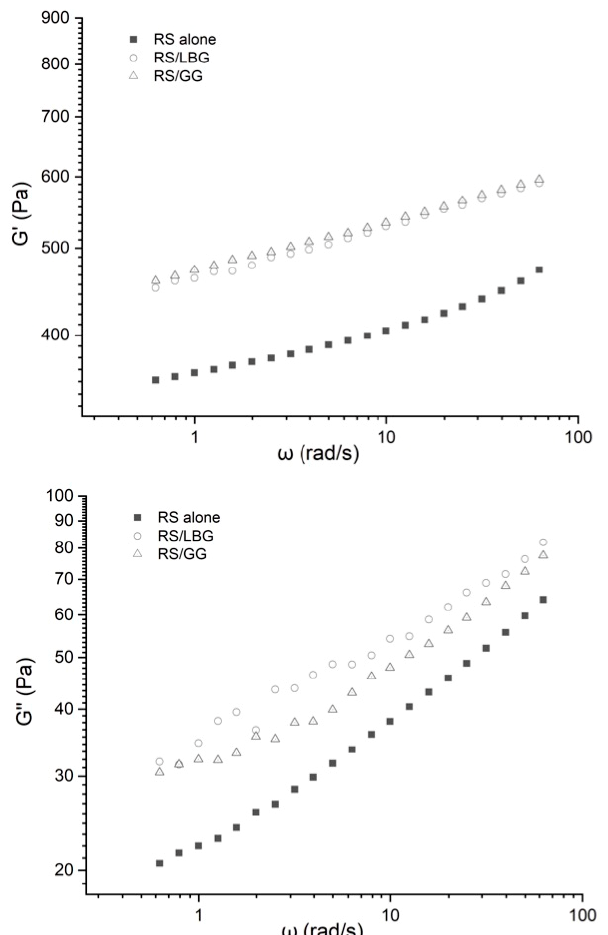
Figure 2. Storage modulus and loss modulus of RS alone, RS containing locust bean gum (RS/LBG), and RS containing guar gum (RS/GG).